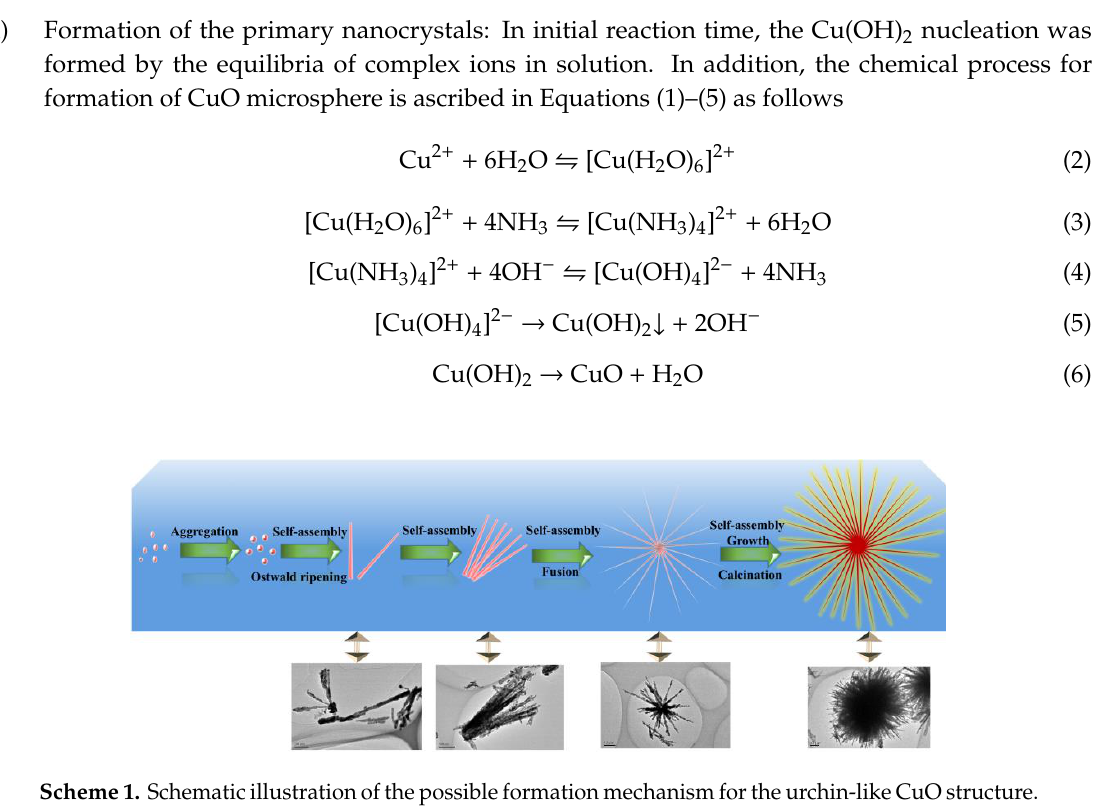
Figure 3. Full XRD patterns of CuO support and Au X /CuO-300 catalysts with various gold loadings. 3.4. TEM